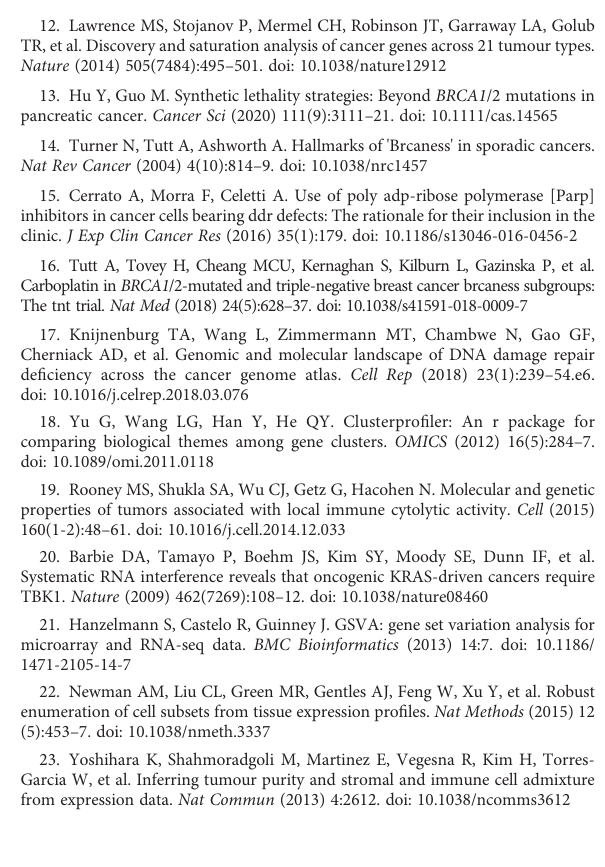
SUPPLEMENTARY FIGURE 4 RT-qPCR validation of relative expression level of differentially expressed DNA repair genes between breast cancer cell lines and normal breast cell line. Total RNA wasisolated from breastcancer cell lines(MCF7, T47D and MDA-MB-231) and normal breast cell line (MCF-10a). Relative mRNA expression was analyzed by qPCR. (A) UBE2T; (B) NEIL3; (C) EXO1; (D) RECQL4; (E) RAD51; (F) EME1; (G) PARP1; (H) RAD54L; (I)